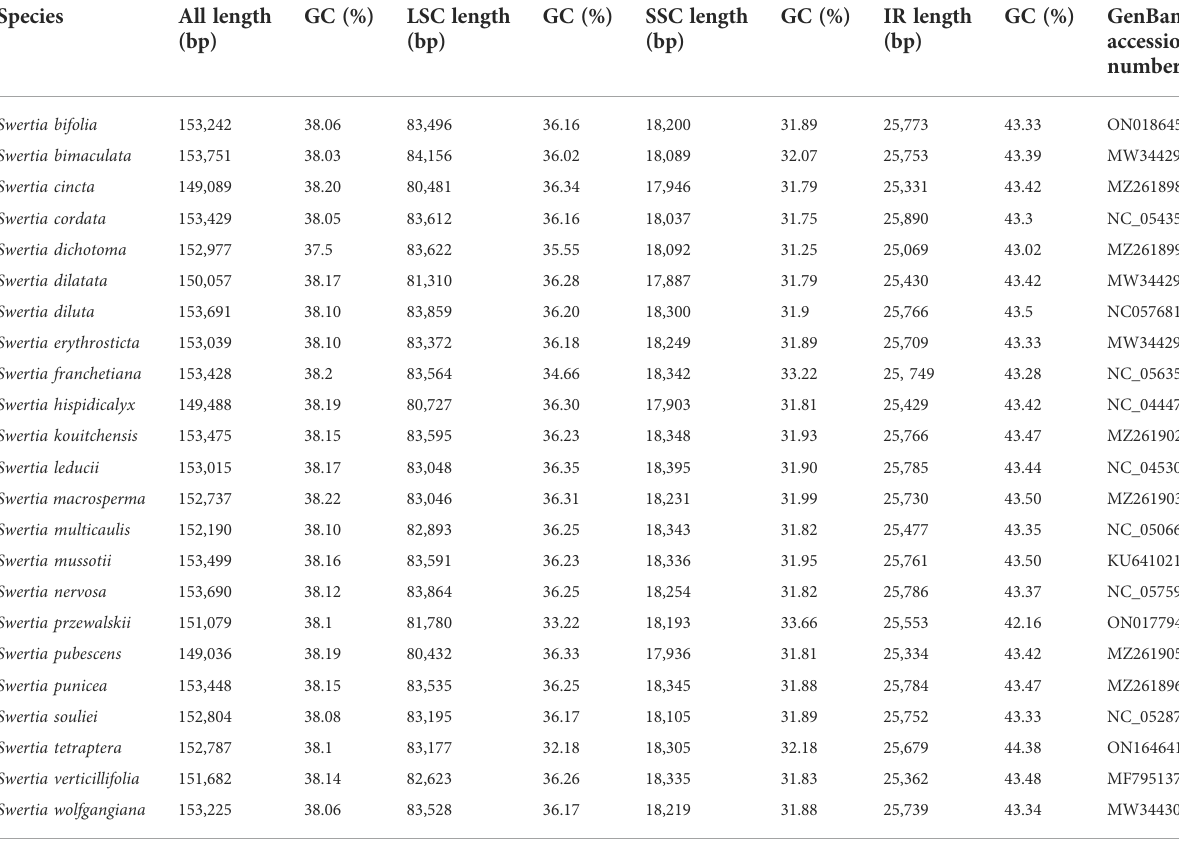
TABLE 1 Complete genome features of Swertia L.